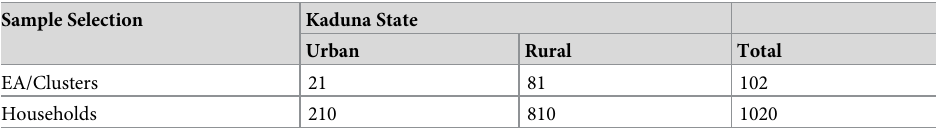
Table 1. Sample allocation of clusters and households by residence for Kaduna state. Sample